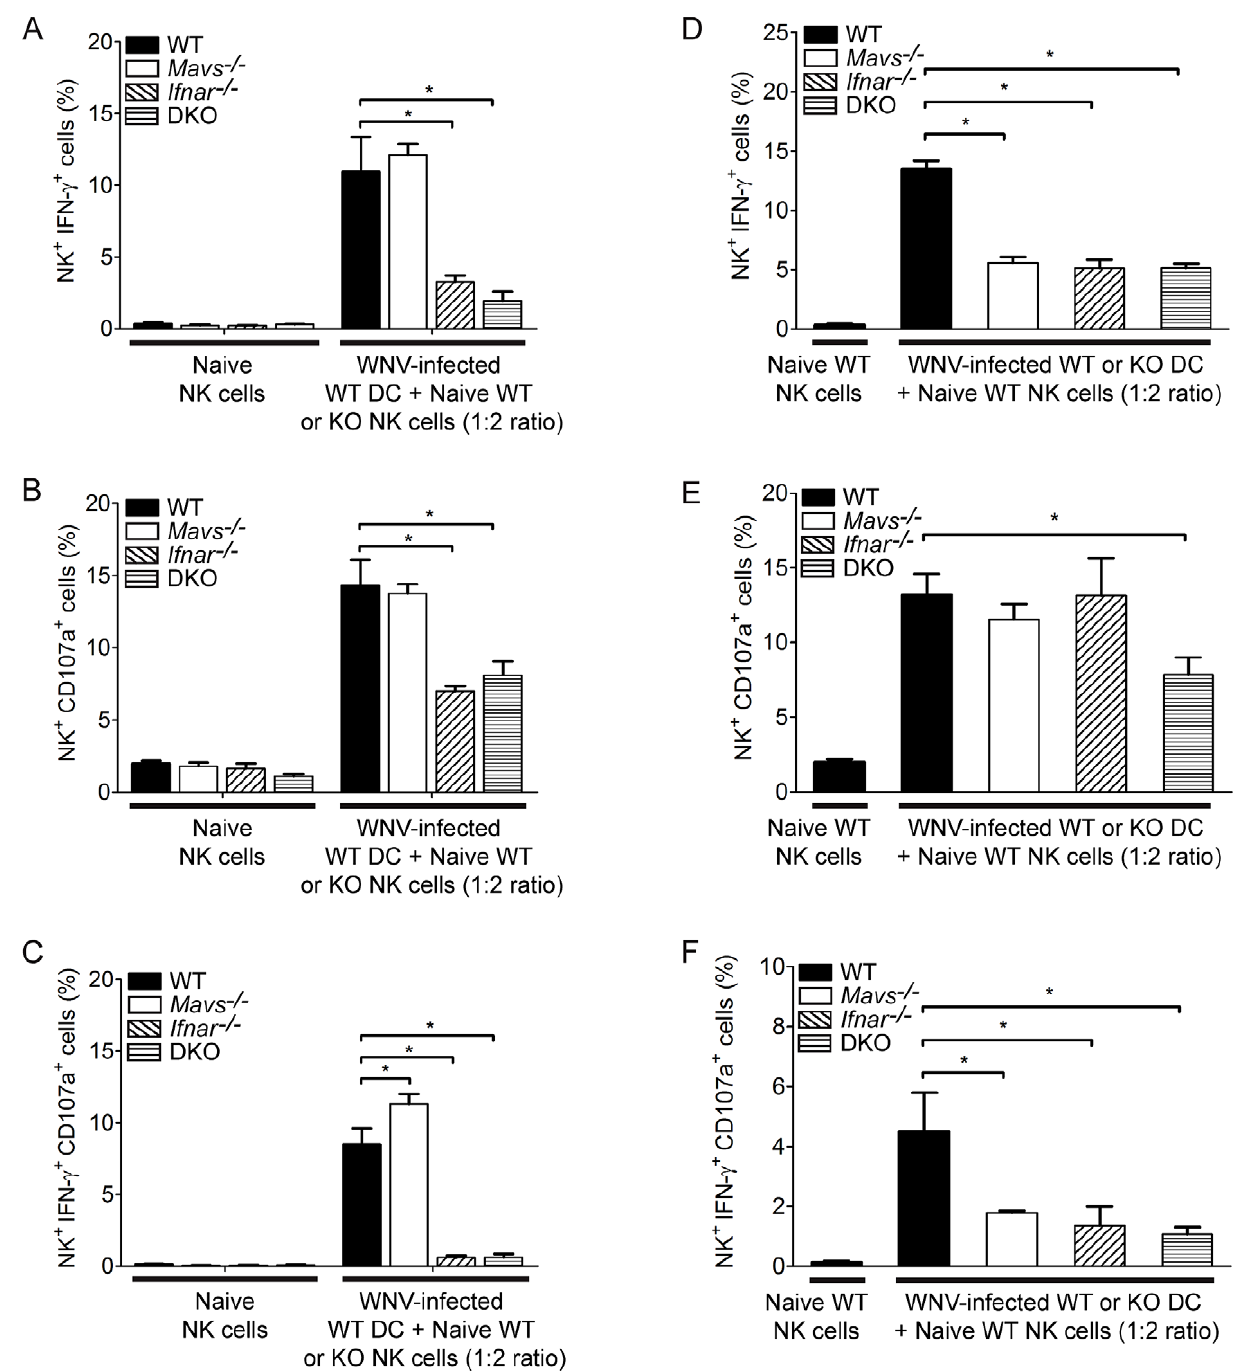
Figure 8. Type I IFN functions in a cell-intrinsic manner to regulate NK cell effector functions. ( A–C ) Bone-marrow derived dendritic cells from WT mice were infected at an MOI of 5.0 with WNV-TX and cultured together with purified NK cells (CD3 e 2 NK1.1 + ) from either WT, Mavs 2 / 2 , Ifnar 2 / 2 , and DKO mice. At 18 hours post-coculture, cells were collected, stained, and analyzed by flow cytometry. As a control, a subset of NK cells were analyzed prior to coculture with BM-DCs (naı¨ve). ( A ) Percent IFN- c + , ( B ) Percent CD107a + , ( C ) Percent IFN- c + CD107a + NK cells are shown. Bone- marrow derived dendritic cells from WT, Mavs 2 / 2 , Ifnar 2 / 2 , and DKO mice were infected at an MOI of 5.0 with WNV-TX and cultured together with purified natural killer cells from WT mice and evaluated by flow cytometry. ( D ) Percent IFN- c + , ( E ) Percent CD107a + , ( F ) Percent IFN- c + CD107a + NK cells are shown. Graphs show the mean + / 2 standard deviation (n=3). Asterisks denote P , 0.05. The data are representative of two or more independent experiments.